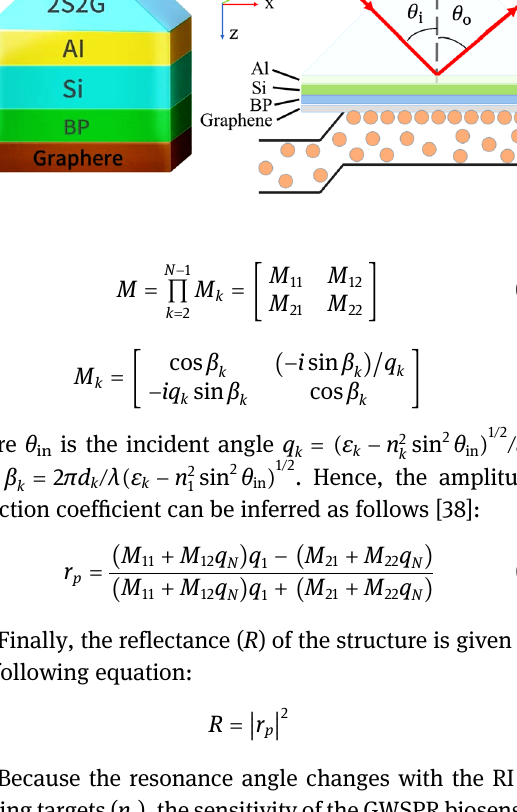
Figure 1: Scheme diagram of the guided- wave surface plasmon resonance (GWSPR) biosensor with a BP – graphene hybrid structure. (a) Structure and (b) work princi- ple of the GWSPR biosensor. BP,